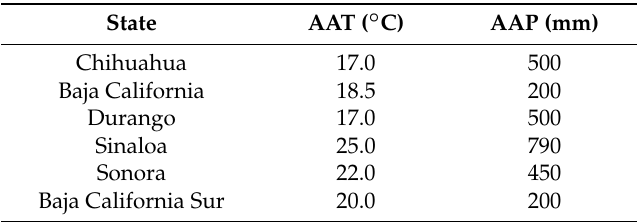
Table 1. Annual average temperature (AAT, ◦ C) and annual average precipitation (AAP, mm) in northern Mexico by state. Source: Authors, from (INEGI, (2011)